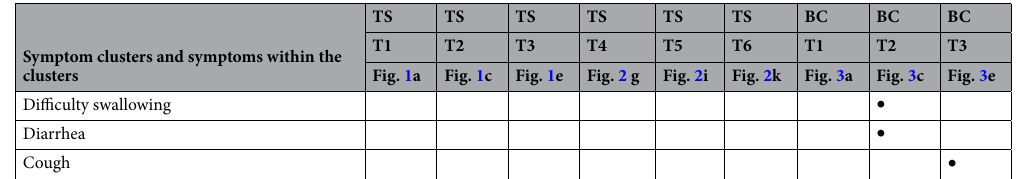
Fig. 1a Fig. 1c Fig. 1e Fig. 2 g Fig. 2i Fig. 2k Fig. 3a Fig. 3c Fig.